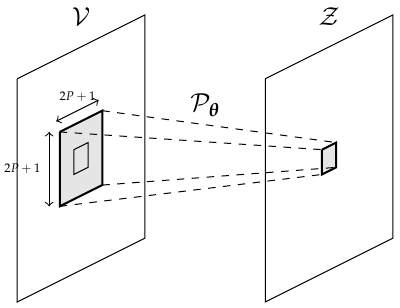
Figure 3. Predictive model working at a local level.